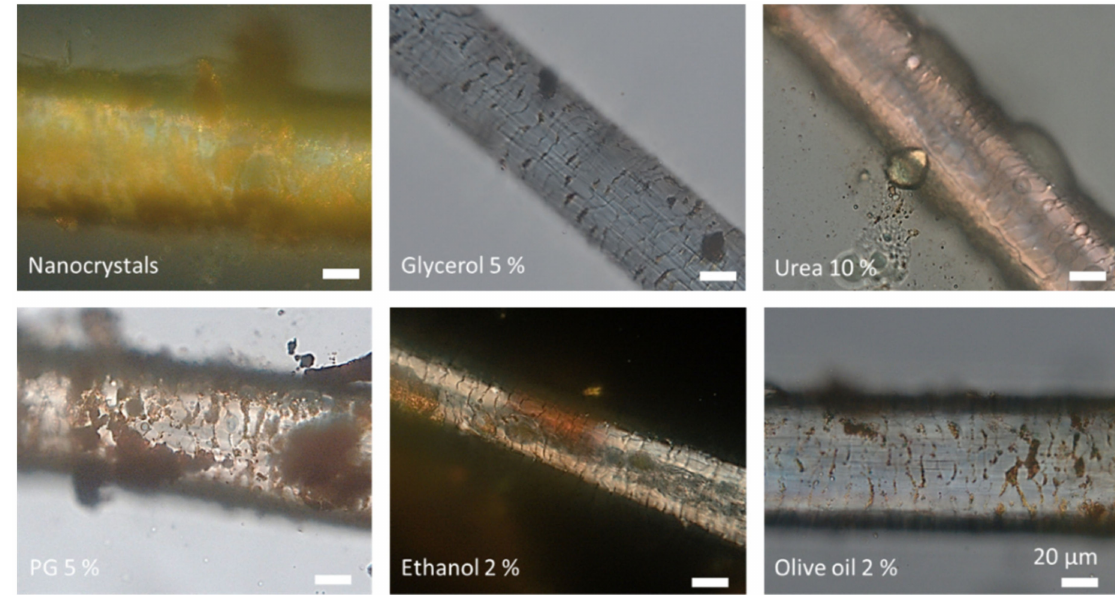
Figure 13. Microscopic images of hairs removed from porcine ears treated with nanosuspensions without and with excipients after addition of dispersion medium (digital zoom of images taken at 400-fold